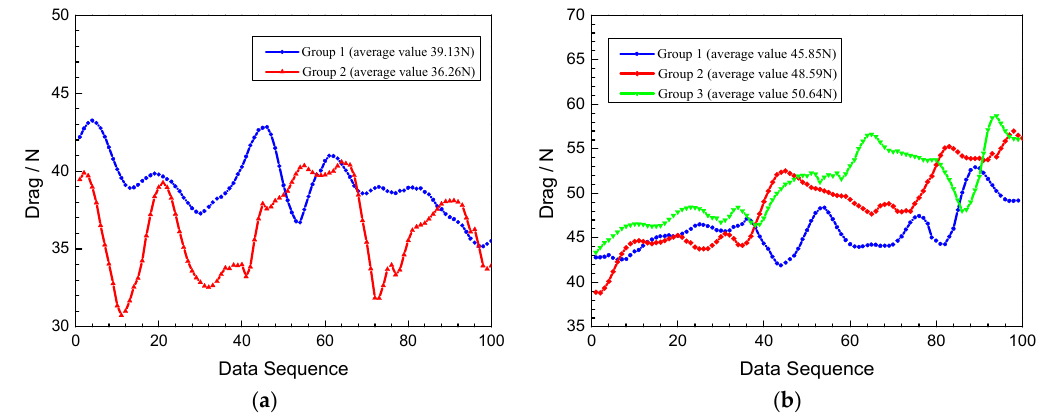
Figure 6. Local drag results of the packer in the horizontal hole: ( a ) The hole with little cuttings; and ( b ) the hole with lots of cuttings.